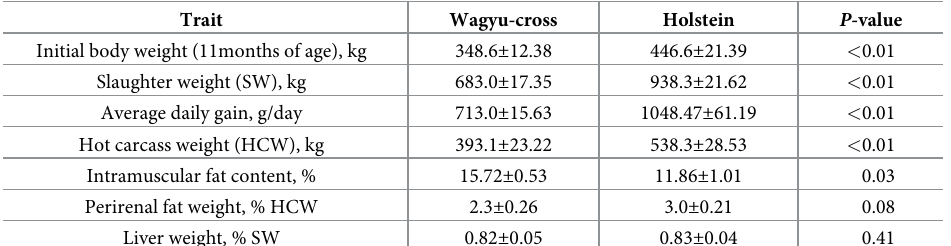
Table 3. Phenotypic data of Wagyu-cross and Holstein steers at 26 months of age (LSMEAN ±